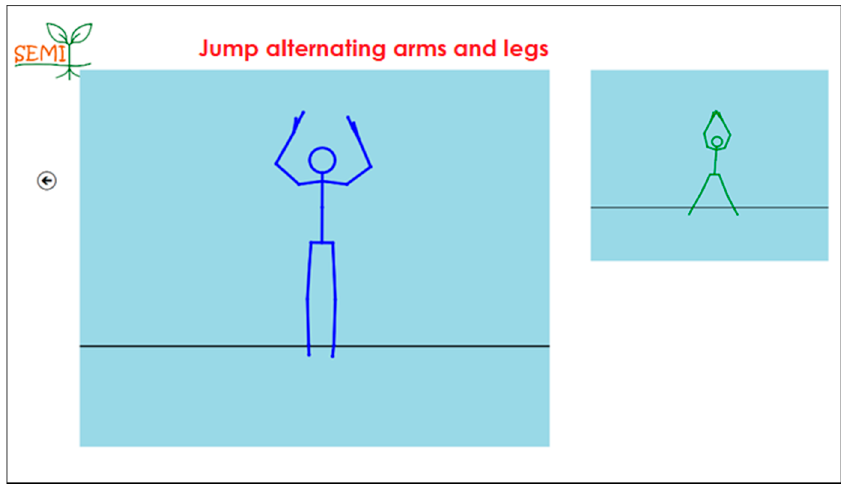
Figure 3. “Repeat the movements” main panel.